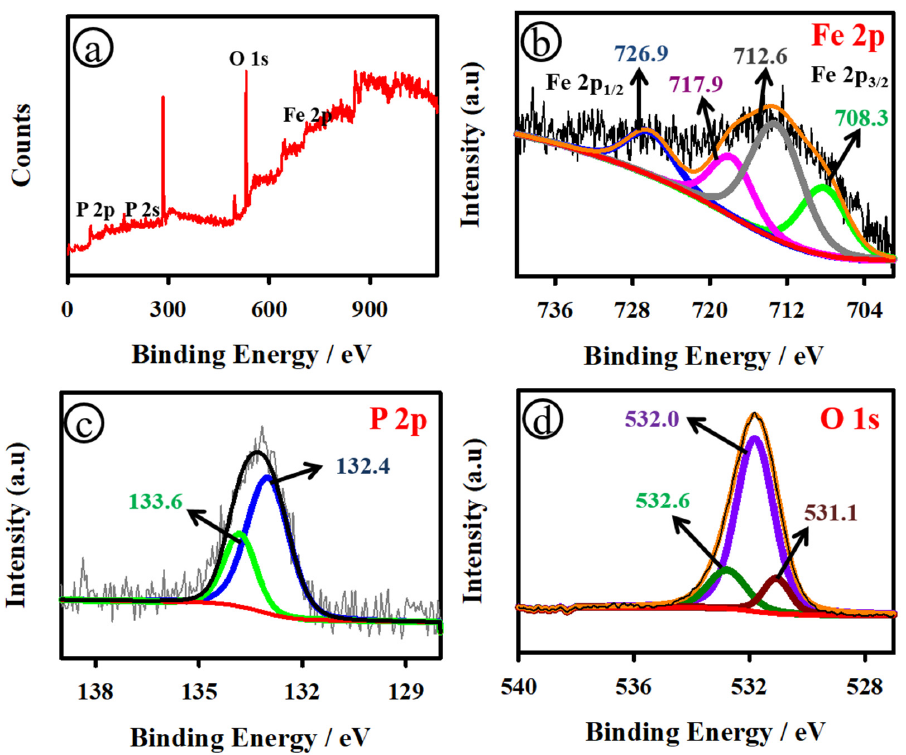
Figure 5. ( a ) XPS survey spectrum of the FeP and high-resolution XPS spectra of ( b ) Fe 2p, ( c ) P 2p, and ( d ) O 1s spectra.